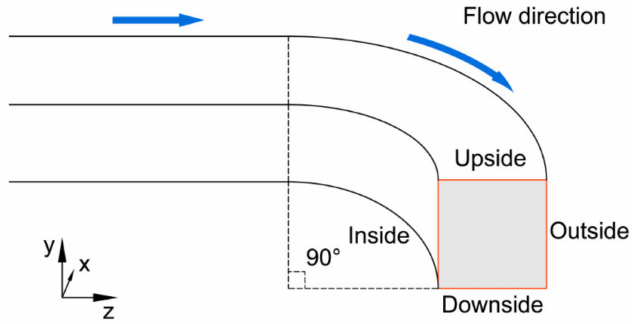
Figure 7. U-shaped channel middle